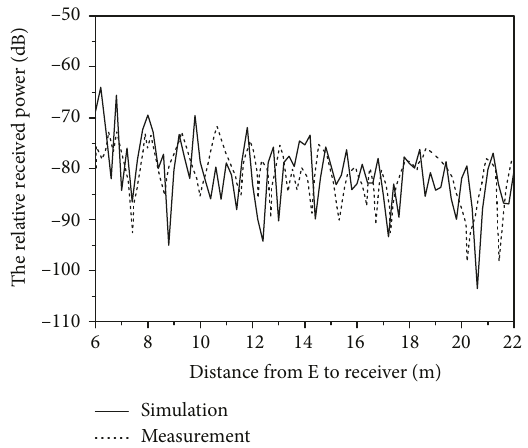
Figure 6: The relative received power from C to D in the NLOS corridor ( N = 10 , M = 8 , G T = 13 dBi, and G R = 1 dBi).